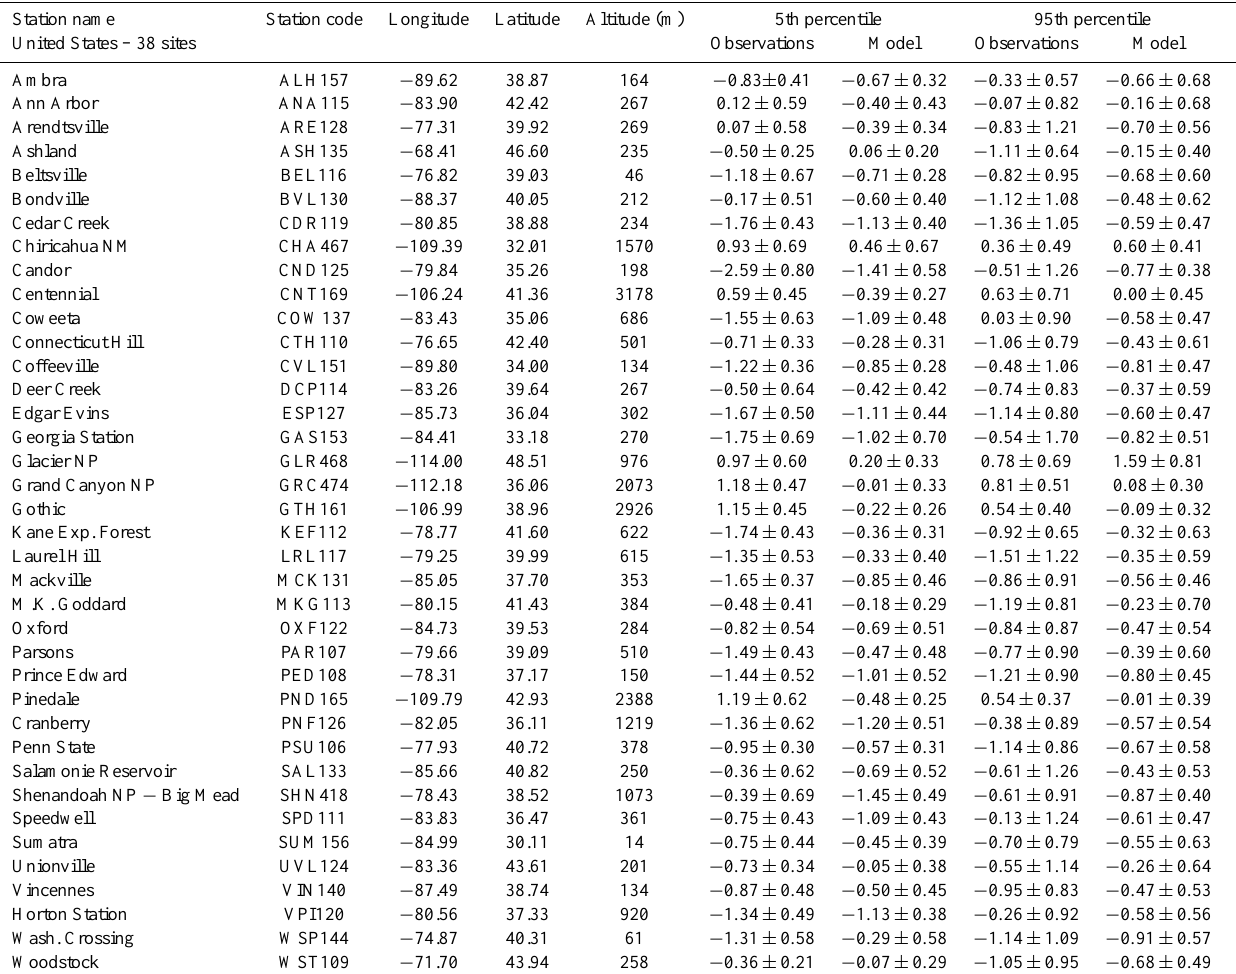
Table A2. Geographical information together with observed and simulated O 3 trend values (in ppb per year) for the 5th and 95th percentiles for each site studied in the